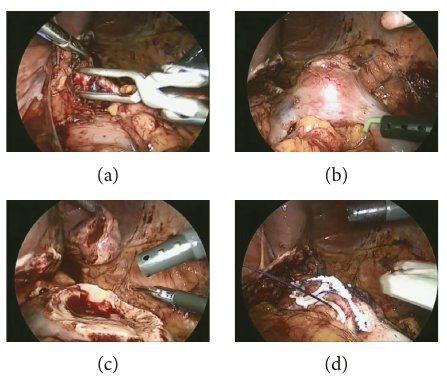
Figure 3: Laparoscopic fi ndings. (a) Left renal artery, (b) tumor, (c) after partial nephrectomy, and (d) after suturing.